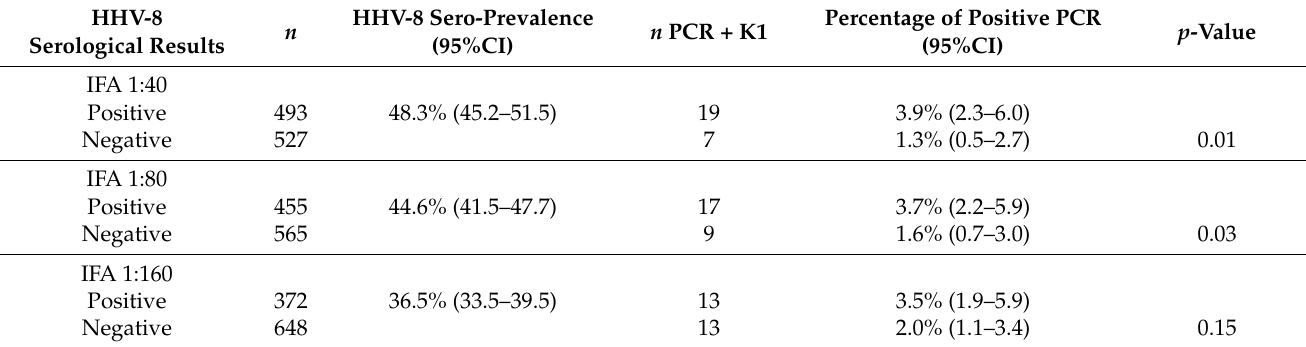
Table 2. HHV-8 PCR results according to serological status at the three dilutions (1:40, 1:80, 1:160).